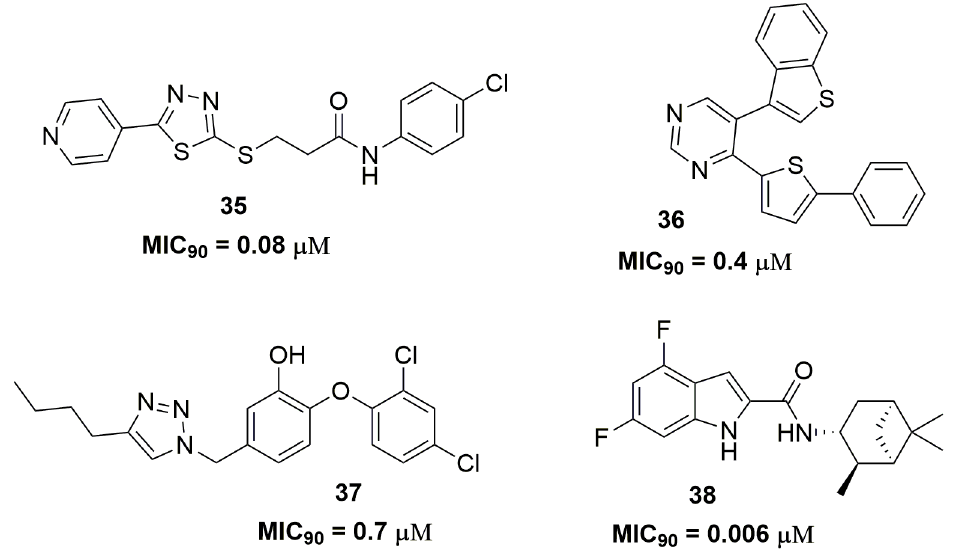
Figure 12. Sulfur-containing compounds, triazole and indole as potent anti-TB agents.